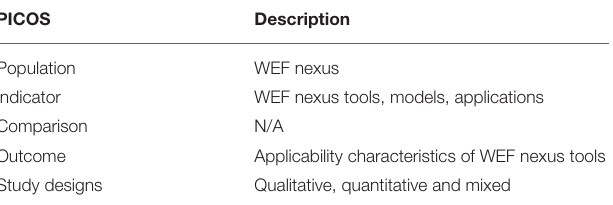
TABLE 3 | Definitions of characteristics of WEF nexus